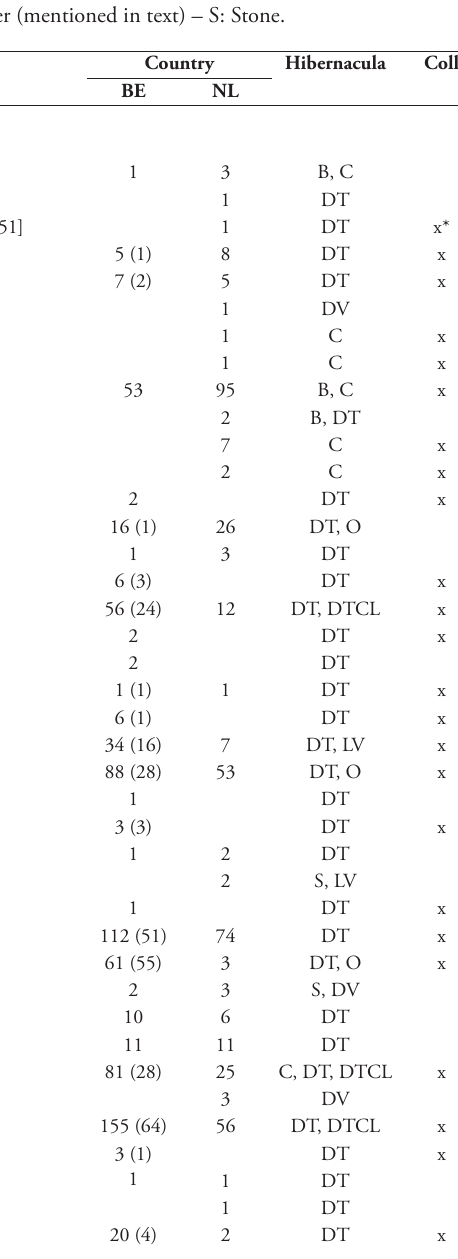
Table 3. Preliminary checklist of species hibernating as adults in Belgium and the Netherlands with number of unique records (author results in parenthesis). Record = finding at one specific locality at one moment in time, unrelated to individual numbers at that locality* = Reported as adult hibernator for the first timeColl. = Hibernating species in collection of the author or someone else*Hibernacula = B: Building – C: Cave – DT: Dead tree – DTCL: Dead tree clay – DV: Decaying vegetation – LV: